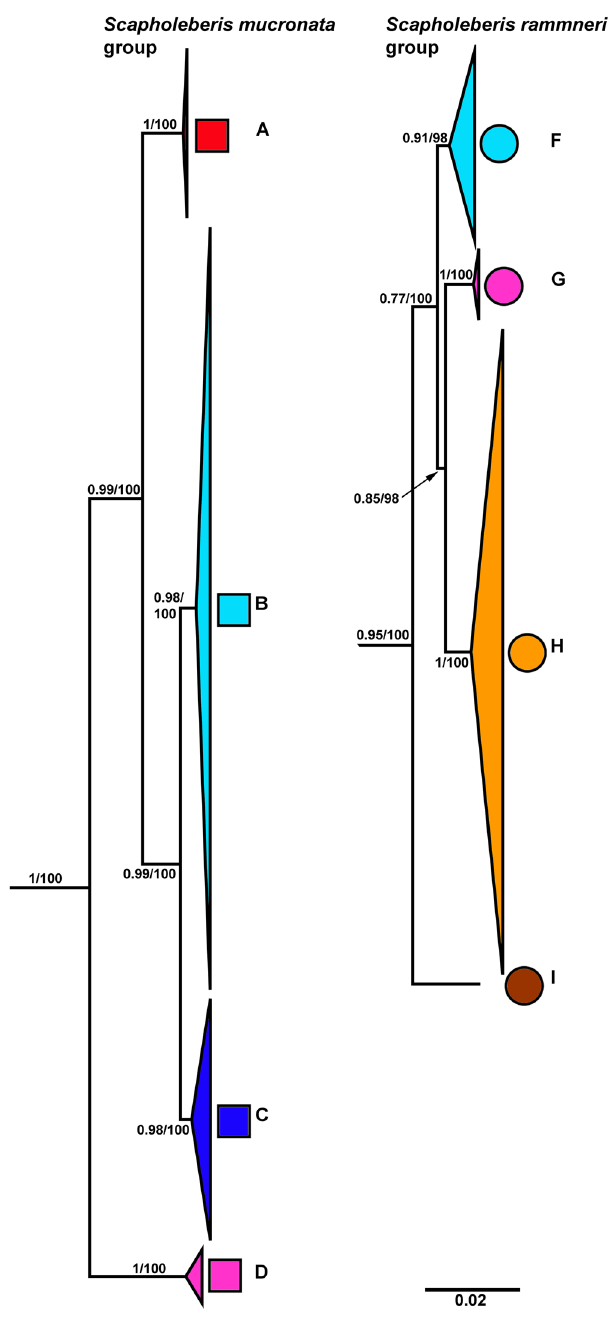
Figure 3. Expanded regions of the Maximum likelihood mitochondrial phylogeny in Fig. 2. Geographic clades of the Scapholeberis mucronata group (left) and the Scapholeberis rammneri group (right) are depicted. Bold letters ( A–D , F–I ) indicate geographic clade names from Fig. 2. Numbers at the nodes indicate approximate likelihood ratio tests (aLRTs)/nonparametric bootstrap support. See Appendix S2 for an outgroup rooted tree and a tree expanded to show individual